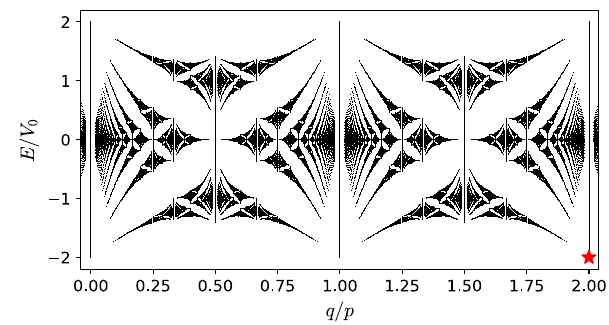
FIG. 3. Hofstadter ’ s butterfly obtained by plotting the spectrum of the effective lowest Landau-level Hamiltonian H defined in Eq. (24), as function of the inverse magnetic flux ratio Φ 0 = Φ ¼ q=p . The two-dimensional GKP code space = ℏ ω n þ corresponds to the states of minimal energy at p=q ¼ 1 = 2 . This n c ¼ point is marked by a red star in the